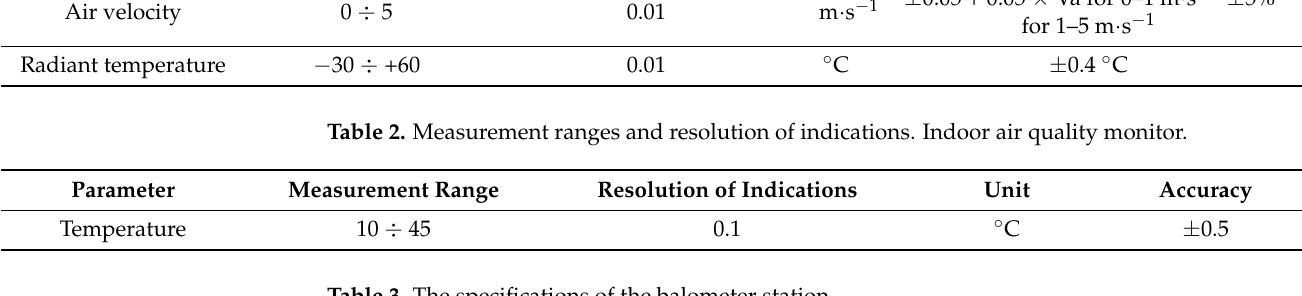
Table 3. The specifications of the balometer